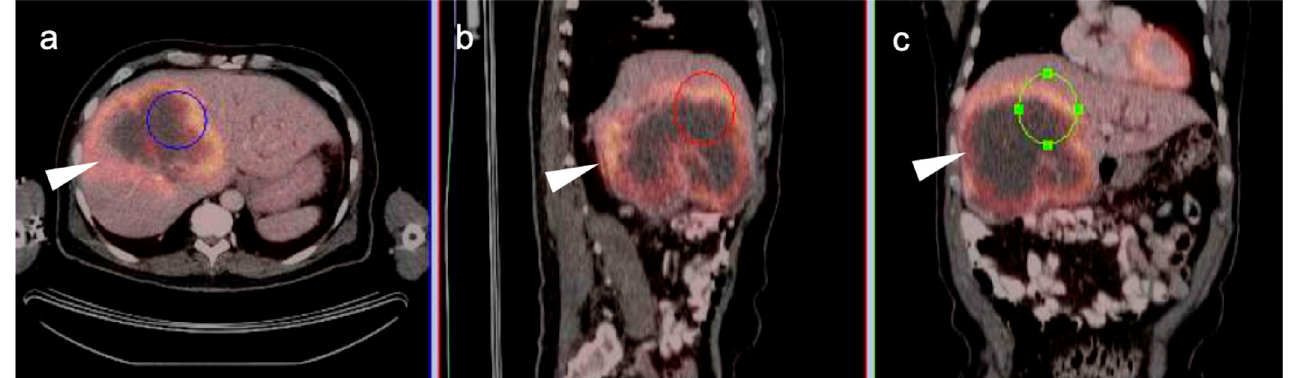
Figure 18. Intrahepatic cholangiocarcinoma. Axial ( a ), sagittal ( b ) and coronal ( c ) projections of a fused FDG PET-CT scan show a typical hypermetabolic ring-shaped area of increased metabolic activity with central necrosis (white arrowheads). SUVmax in shown region of interest (ROI) is 10.3.